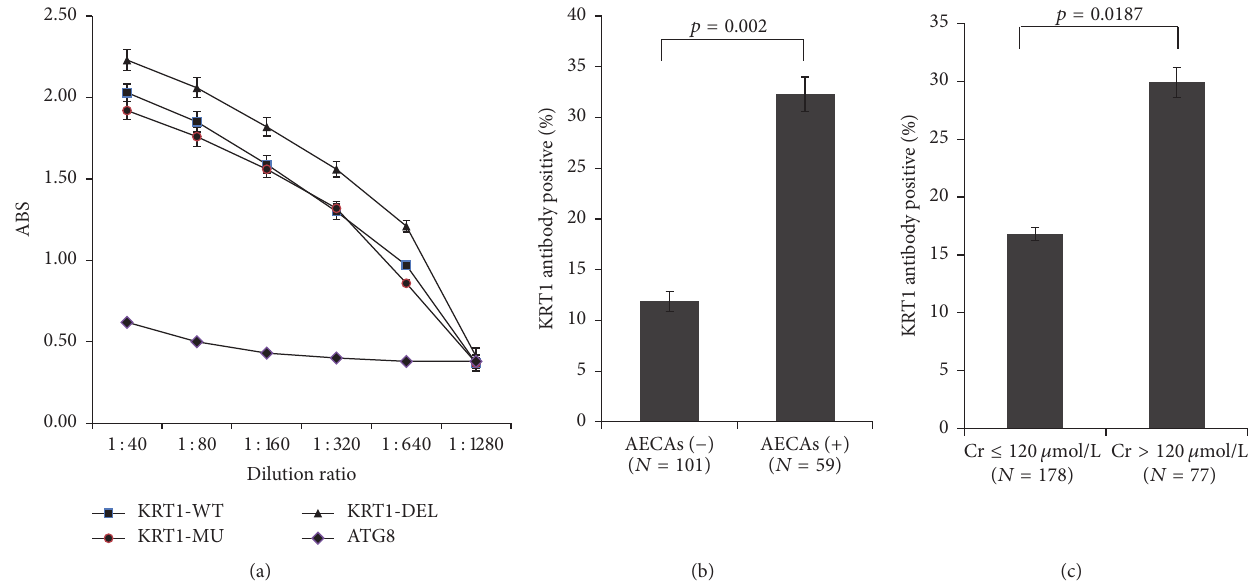
Figure 5: Incidence of KRT1-specific antibodies in kidney transplant recipient serum samples. (a) Serum samples were analyzed using ELISAs for three KRT1 recombinants (KRT1-WT, KRT1-MU, and KRT1-DEL) and ATG8/GABARAPL1. The absorbance at 405 nm is plotted as a function of concentration of serum S5. (b) Percentages of KRT1-positive recipients in AECA-positive and AECA-negative groups. (c) Percentages of KRT1-positive recipients in subjects with serum creatinine level ≤ 120 𝜇 mol/L and subjects with serum creatinine level > 120 𝜇 mol/L. The statistic 𝑝 values are